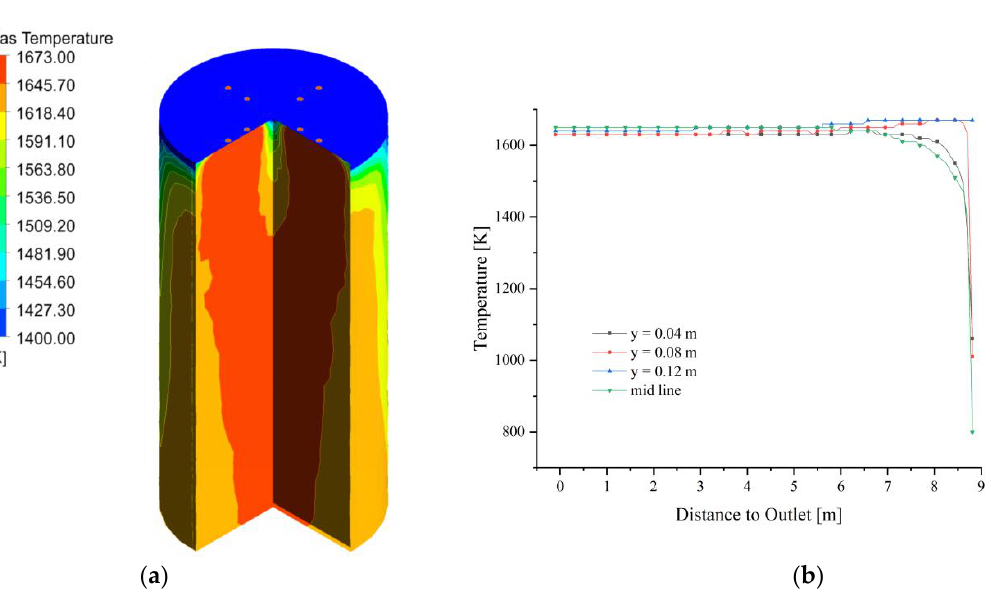
Figure 7. Gas temperature field at 40 mm and 80 mm. ( a ) Gas temperature; ( b ) Gas temperature changes in y = 0.04, 0.08, 0.12 m, and mid line.